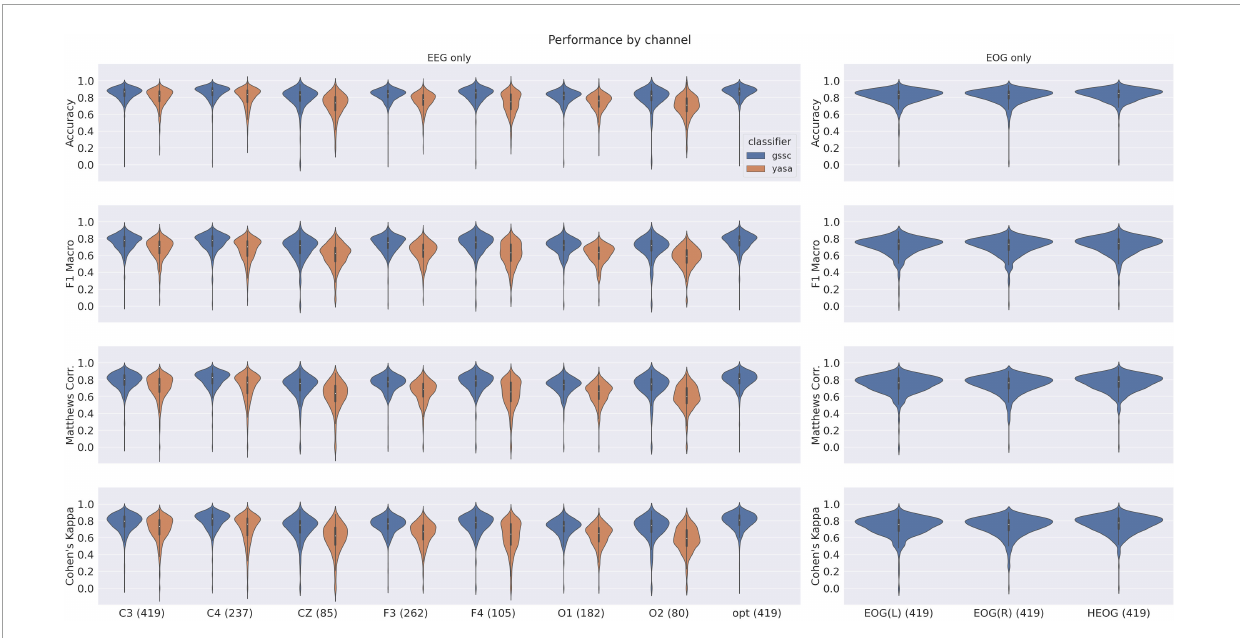
FIGURE7 Violin plots for single-channel performance on the testing datasets for YASA and Greifswald Sleep Stage Classifier (GSSC). Measures shown here include Accuracy, F1 Macro, Matthews Correlation Coefficient and Cohen’s Kappa. Numbers in parentheses by the dataset name indicate the number of PSGs which had that channel available.